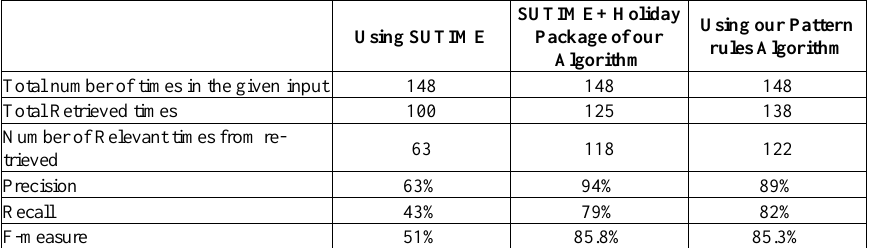
Table 4. Accuracy of the Results (with Precision, Recall, F-measure) Using